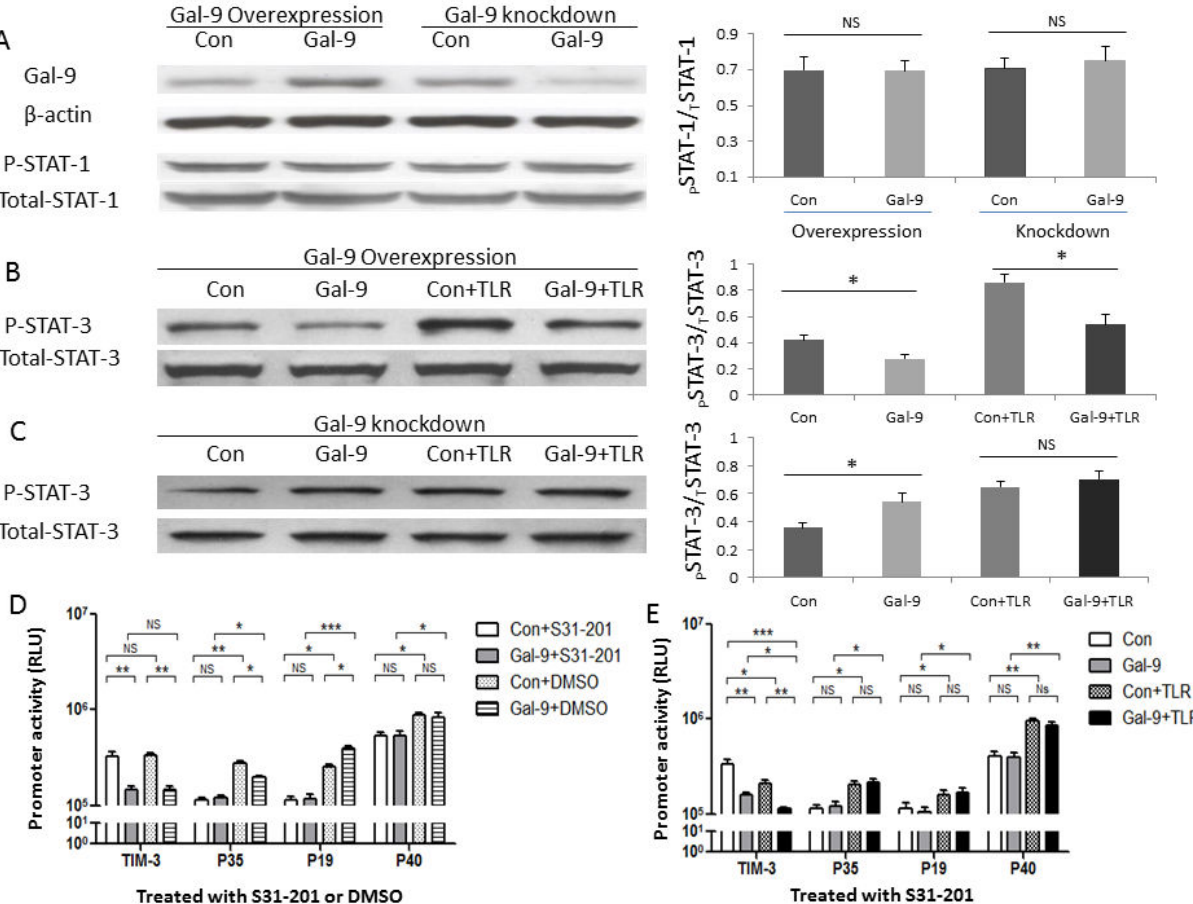
Figure 2. Gal-9 differentially regulates IL-12 and IL-23 gene transcriptions in THP-1 cells through STAT-3 signaling. A) Western blot detection of Gal-9 and phosphorylation of STAT-1 proteins in THP-1 cells transfected with Gal-9 plasmid or siRNA. THP-1 cells were transfected with either pBKCMV3-Gal-9 plasmid (Gal-9) or pBKCMV3 empty vector (Con), or Gal-9 silencing siRNA or control siRNA. After 24~48 h transfection, the cells were subjected to Western blot analysis of Gal-9 and pSTAT-1 proteins. β-actin or total STAT-1 served as loading control to normalize target gene levels. Data are shown as representative imaging (left) and corrected optimal densitometry (O.D.) values from three independent experiments for STAT-1 (right). NS = no significance. B) Western blot detection of pSTAT-3 protein in THP-1 cells transfected with Gal-9 plasmid in the presence or absence of TLR stimulations. THP-1 cells were transfected with either Gal-9 or Control plasmid for 24 h, stimulated with or without LPS/R848 for 6 h, followed by Western blot analysis of pSTAT-3 protein. Total STAT-3 served as loading control to normalize target gene levels. Representative imaging and corrected O.D. values from three independent experiments are shown. *P<0.05. C) Western blot detection of pSTAT-3 protein in THP-1 cells transfected with Gal-9 siRNAs with or without TLR stimulations. THP-1 cells were transfected with either Gal-9 or control siRNAs for 48 h, stimulated with or without LPS/R848 for 6 h, followed by Western blot analysis of pSTAT-3 protein. Total STAT-3 served as loading control. Representative results and corrected O.D. values from three experiments are shown. *P<0.05, NS = no significance. D) Luciferase assay for Tim-3, IL-12, IL-23 promoter activities in Gal-9- transfected THP-1 cells in the presence of STAT-3 inhibitor. pBKCMV3-Gal-9 or control plasmid was transfected into THP-1 cells, along with Tim-3, IL-12p35, IL-23p19, or IL-12/IL-23p40 promoter reporter vectors, in the presence of STAT3-specific inhibitor or DMSO for 24 h, followed by luciferase assays. Data are mean ± SE of triplicate samples for relative luciferase units (RLU). *P<0.05, **P<0.01, ***P<0.001, NS = no significance. E) Intracellular Gal-9 and TLR stimulation on Tim-3, IL-12, IL-23 promoter activities in THP-1 cells treated with STAT-3 inhibitor and TLR stimulation. pBKCMV3-Gal-9 or control vector was transfected into THP-1 cells, along with Tim-3, IL-12p35, IL-23p19, or IL-12/IL-23p40 promoter reporter vectors, in the presence of STAT3-specific inhibitor for 24 h. The cells were stimulated without or with LPS/R848 for 6 h, followed by luciferase assays as described in Methods. Data are mean ± SE of triplicate samples for relative luciferase units (RLU). *P<0.05, **P<0.01, ***P<0.001, NS = no significance.